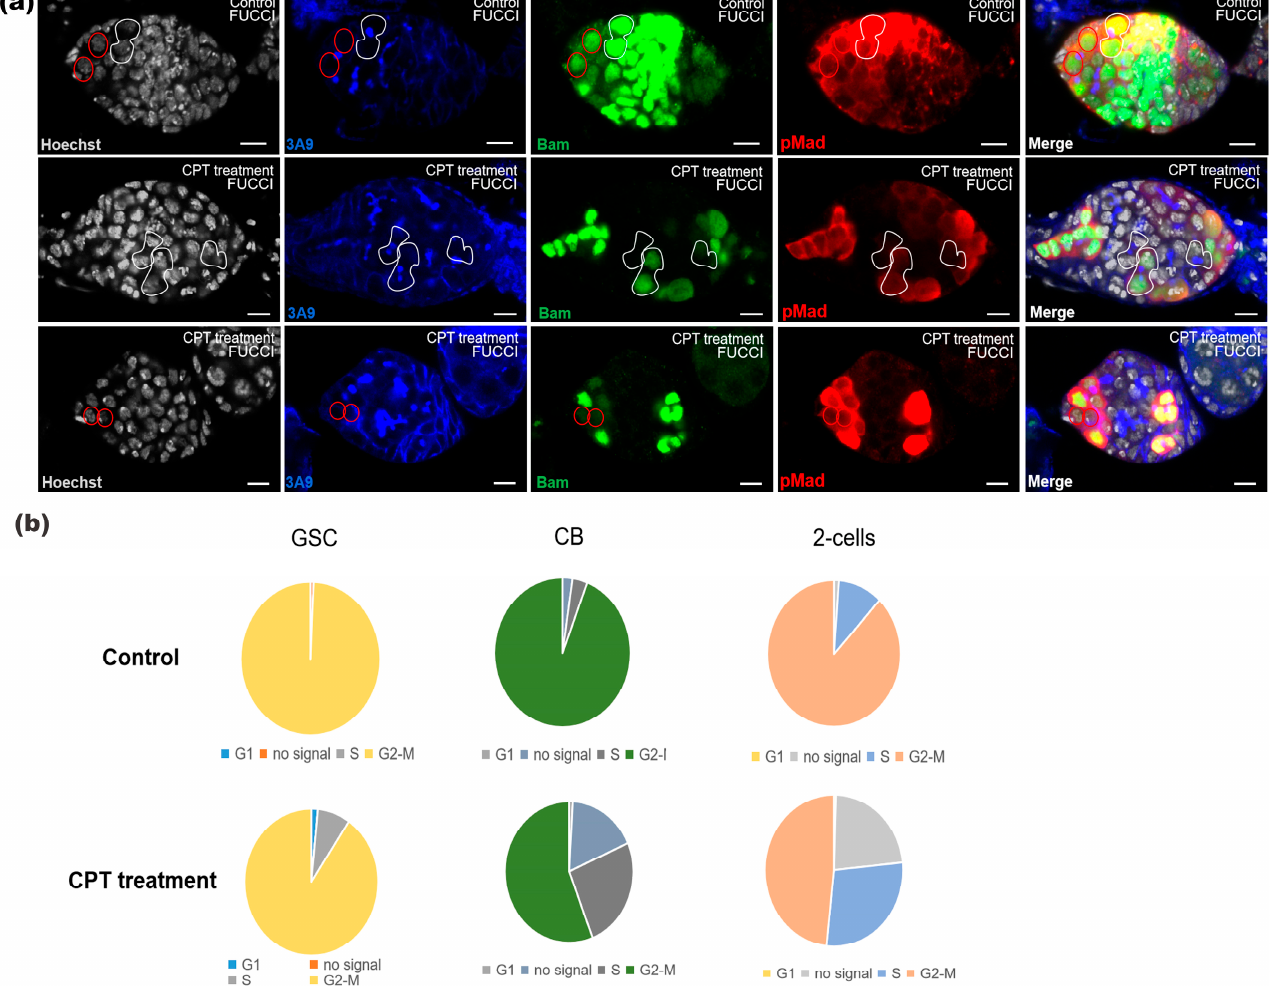
Figure 6. Cell cycle was determined by FUCCI system. ( a ) FUCCI were applied to identify cells in different phases of the cell cycle and stained with Hoechst (white), anti-3A9 (blue), anti-GFP (green), and anti-RFP (red). White dashed circle indicated two-cell without signals. ( b ) Quantification of cells in different phases of cell cycle.